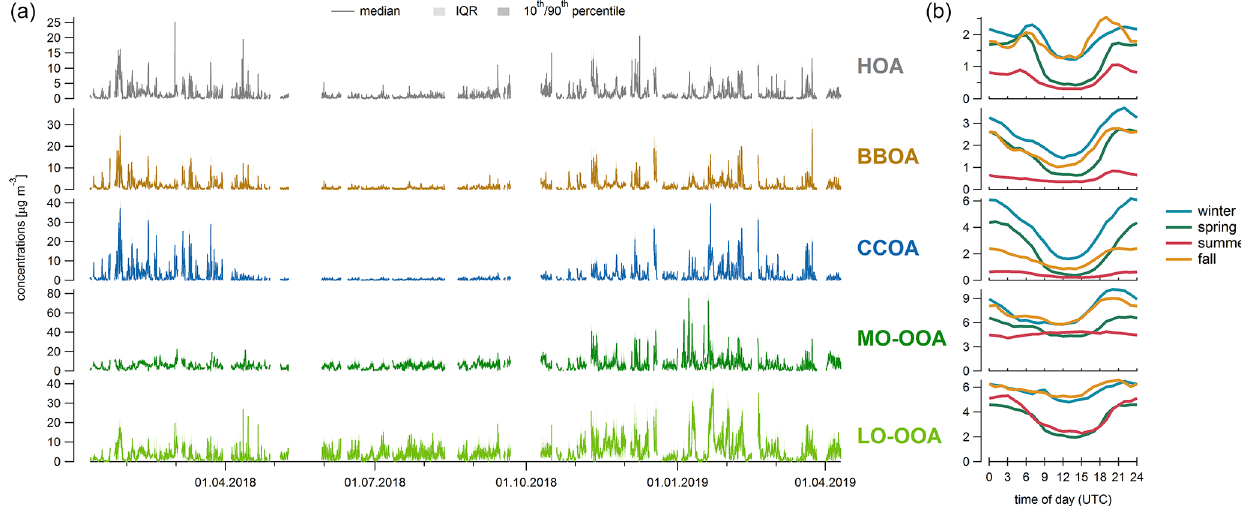
Figure 3. Medians, interquartile ranges (IQRs), and 10th and 90th percentiles of the time series (a) and mean values of the diurnal varia- tions (b) of the five resolved PMF factors. The time is reported in UTC (1 and 2h behind local time during winter and summer,